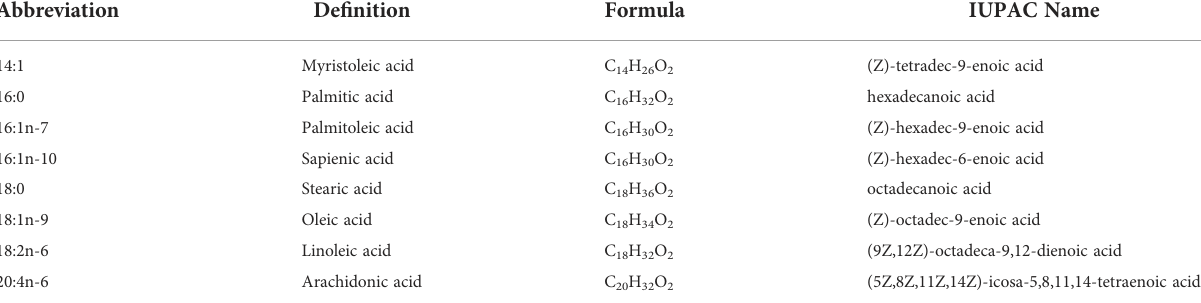
TABLE 3 List of fatty acid